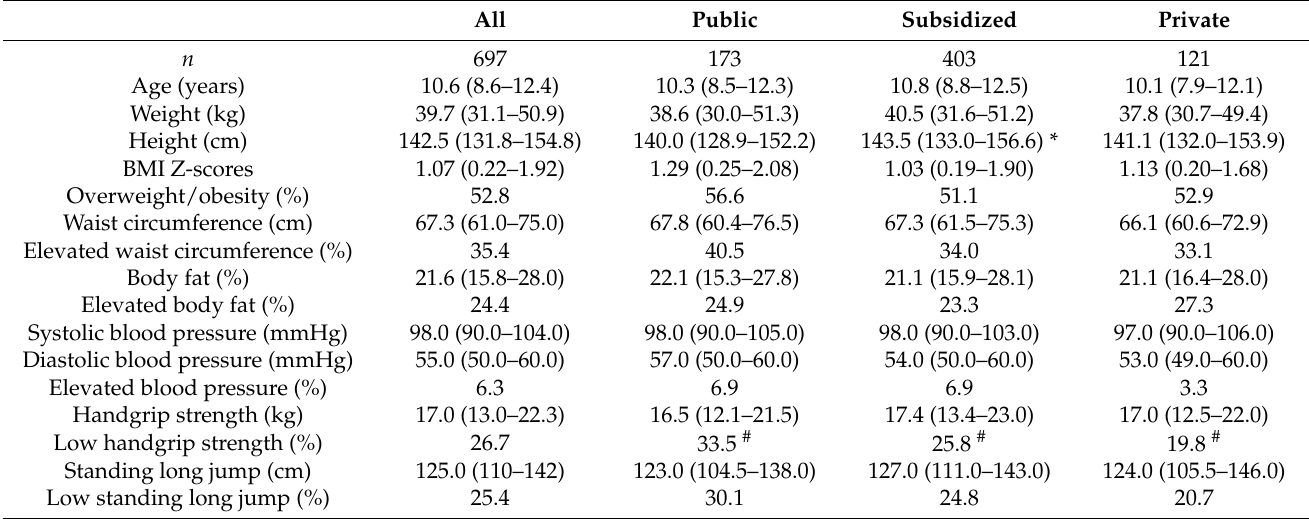
Table 2. Characteristics of boys by school type.